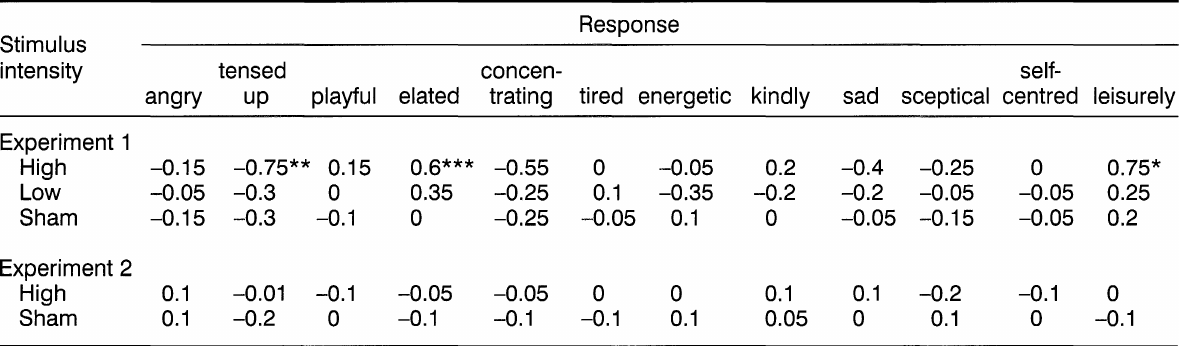
TABLE I. Mean change values of emotions following TSE. Positive values represent an emotion being felt more strongly. Following high intensity TSE, subjects felt significantly more elated (*** = p < 0.001), leisurely (* = p < 0.05) and less tensed up (** = p < 0.01)